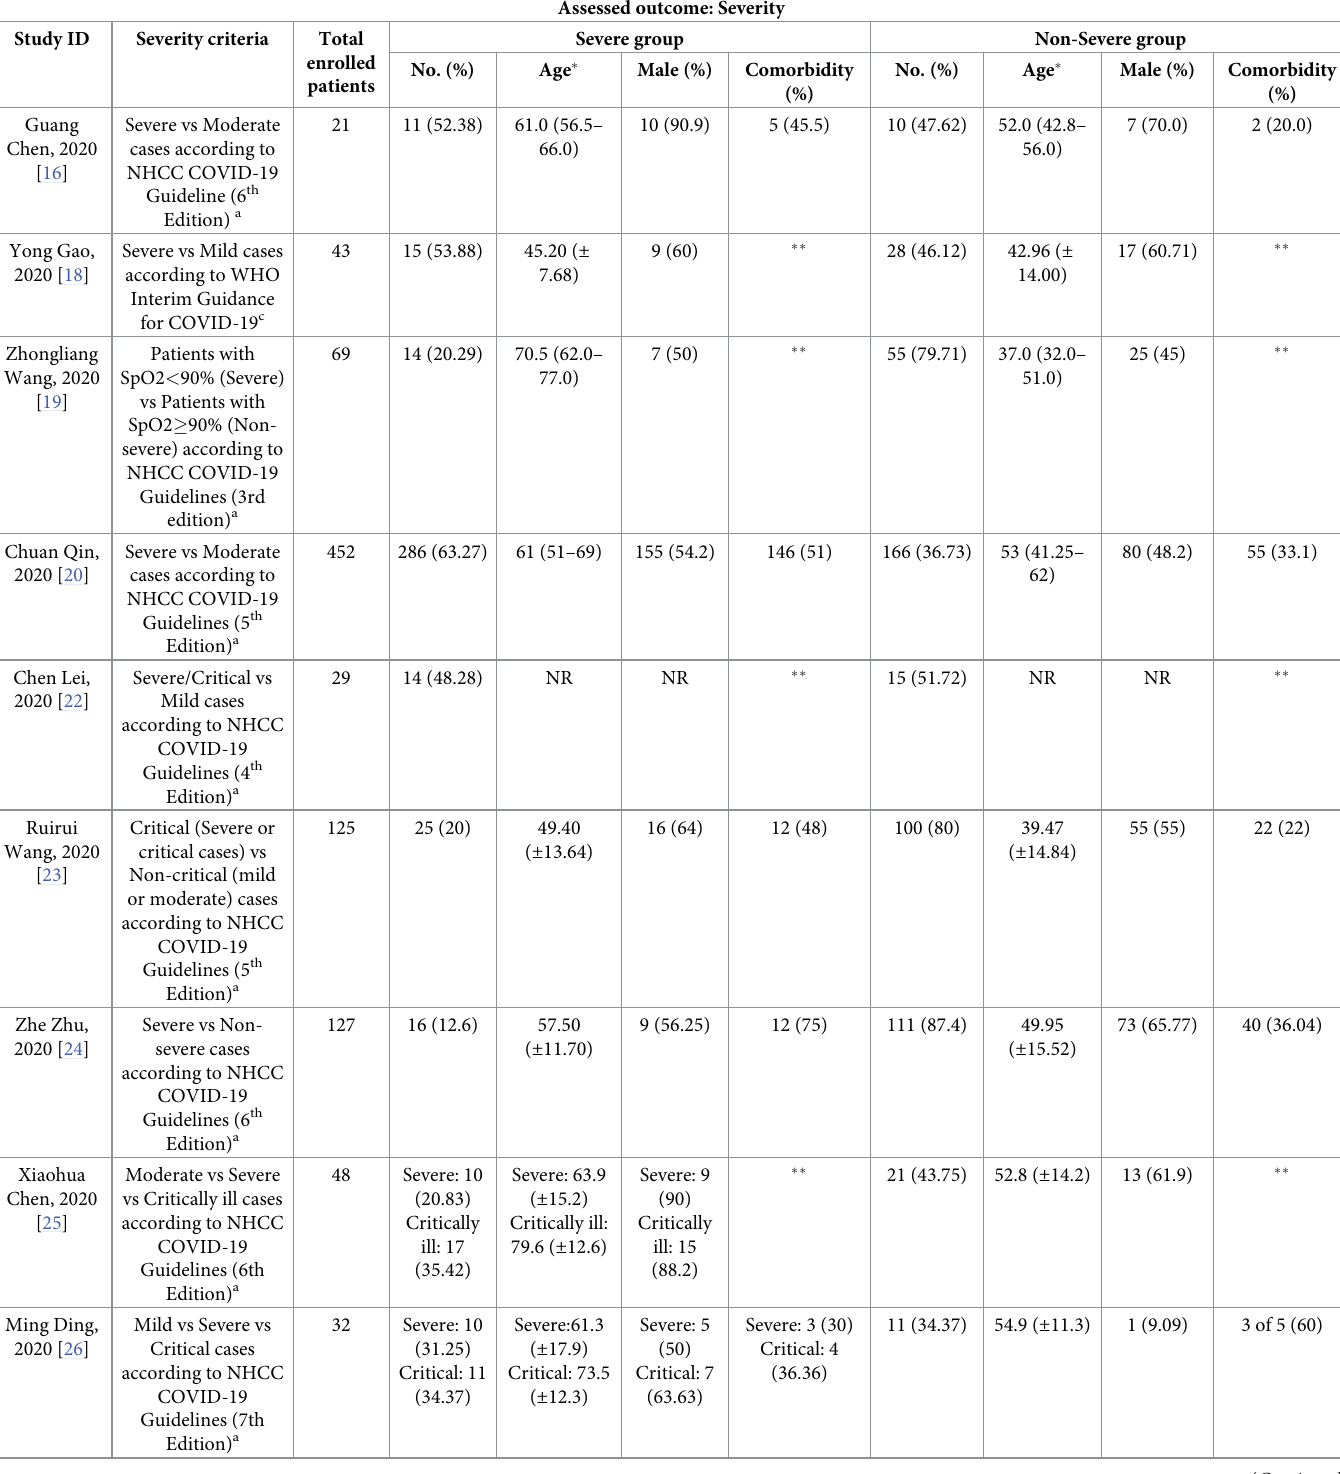
Table 1. Baseline and demographic characteristics of the included